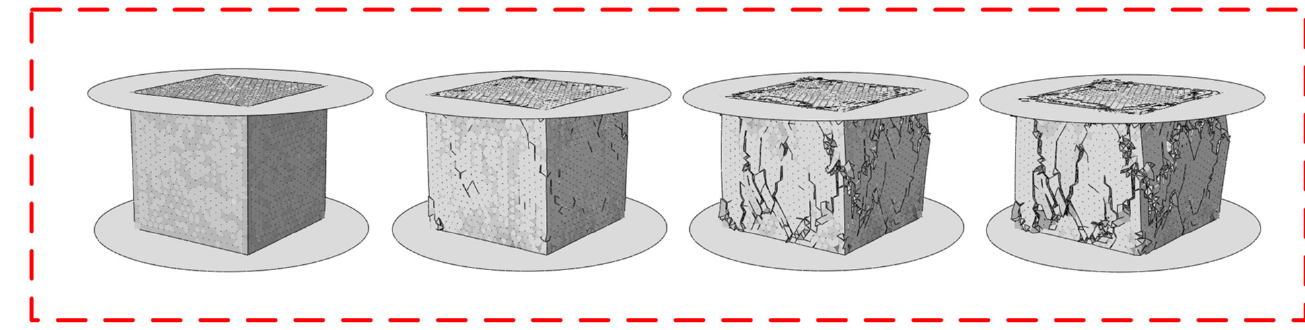
Figure 13. The whole process of the model from intact to damage to crack. Although the data from mesoscale numerical simulation are not completely consistent with the macro test results, the overall trend is similar, which can characterize the uniaxial failure process of the specimen. In the mesoscale numerical simulation, with the increase in the load imposed on the plain concrete, the vertical compression deformation of the specimen occurs, and the horizontal direction extends to the four sides. The constraint effect of the upper and lower bearing plates makes the vertical deformation of the specimen small. There is no constraint in the middle of the specimen, so the horizontal deformation is the largest. The specimen gradually expanded outward from the middle, and with the further increase in pressure, the deformation of the specimen also increased until it finally failed, as shown in Figures 14 and 15. In the rubber concrete model, rubber is regarded as a kind of super elastic material, and the addition of rubber leads to the continuous change of rubber mortar interfacial structure. With the increase in rubber content, the number of rubber–mortar interfacial units, total interfacial units, and initial defect units increased, and the strength of rubber concrete showed a downward trend. The failure states of the PVA rubber/concrete model are divided into damaged and failed. Under a certain load, the elastic modulus of the model decreases gradually, but it still maintains certain mechanical properties, which is called damage. When the load continues to act, the model loses elasticity and its own mechanical properties, which is called failure. The PVA content will certainly improve the strength of rubber concrete. When the content exceeds a certain amount, the addition of PVA will reduce the adhesive force of the rubber concrete matrix and the strength value of rubber concrete, as shown in Figure 16, which is consistent with the conclusion reached by our